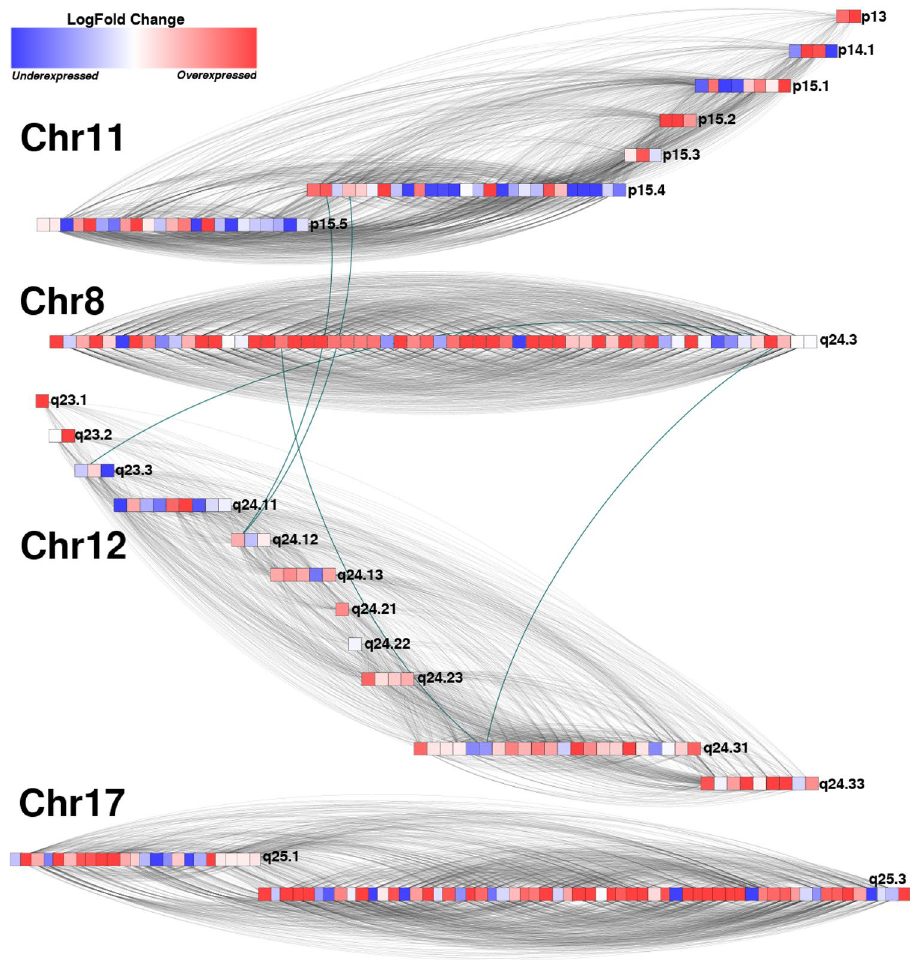
Figure 6. HER2+ 30-core network. In this representation, genes are colored according to their differential expression. Red squares represent overexpressed genes, and blue, underexpressed ones. Grey links join cis- interactions, and blue thicker lines join genes from different chromosomes ( trans- interactions). Each row of genes contains elements from the same cytoband. Each chromosome in the figure forms one community: Chr11, Chr8, Chr12 and